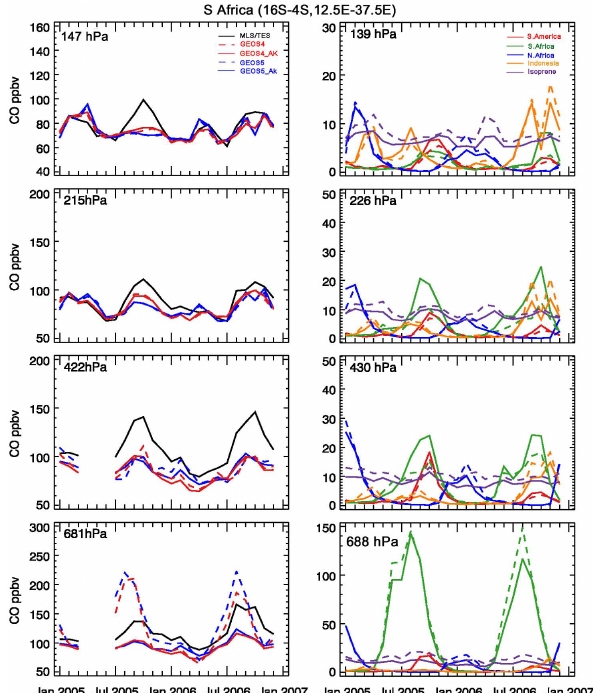
Fig. 17. Left: Time series of TES CO (681 and 422hPa) and MLS CO (215 and 147hPa, scaled as in Fig. 8) (black) and model results for GEOS-4 (red) and GEOS-5 (blue) over southern Africa. Solid lines show the model results with the AKs applied, dashed lines show the model results without the AKs. Right: Time series of tagged CO tracers over southern Africa from individual sources: biomass burning in South America (red), southern Africa (green), northern Africa (blue) and Indonesia (orange), and the biogenic source from isoprene